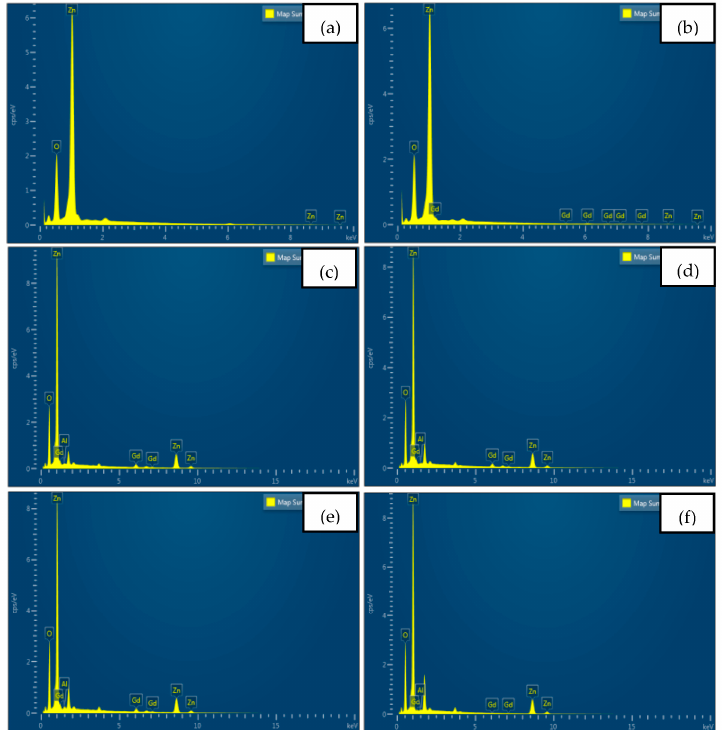
Figure 3. EDX spectrum of ( a ) Undoped ZnO, and (Gd, Al) co-doped ZnO at ( b ) 0 at% Al, ( c ) 1 at% Al, ( d ) 2 at% Al, ( e ) 3 at% Al, ( f ) 4 at% Al. Table 3. The composition of (Gd, Al) co-doped ZnO films at various Al concentrations. Al Concentration (at%) Gd (at%)